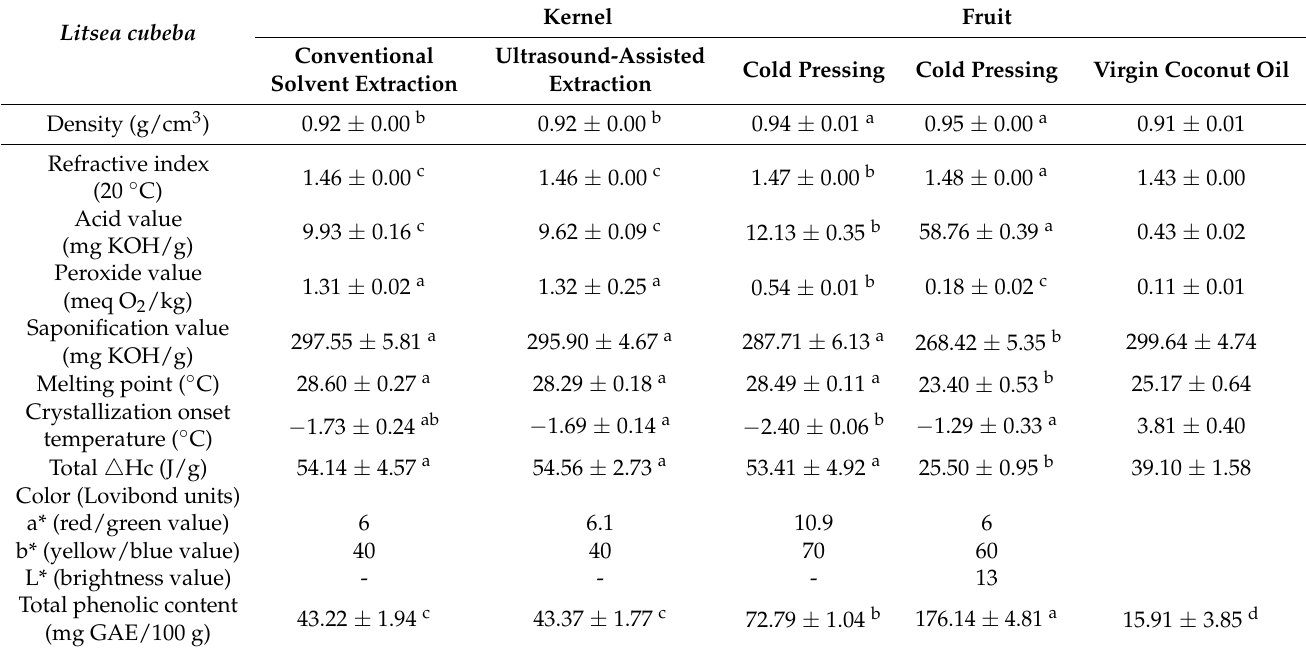
Table 2. The effect of different extraction methods on the physicochemical properties of Litsea cubeba